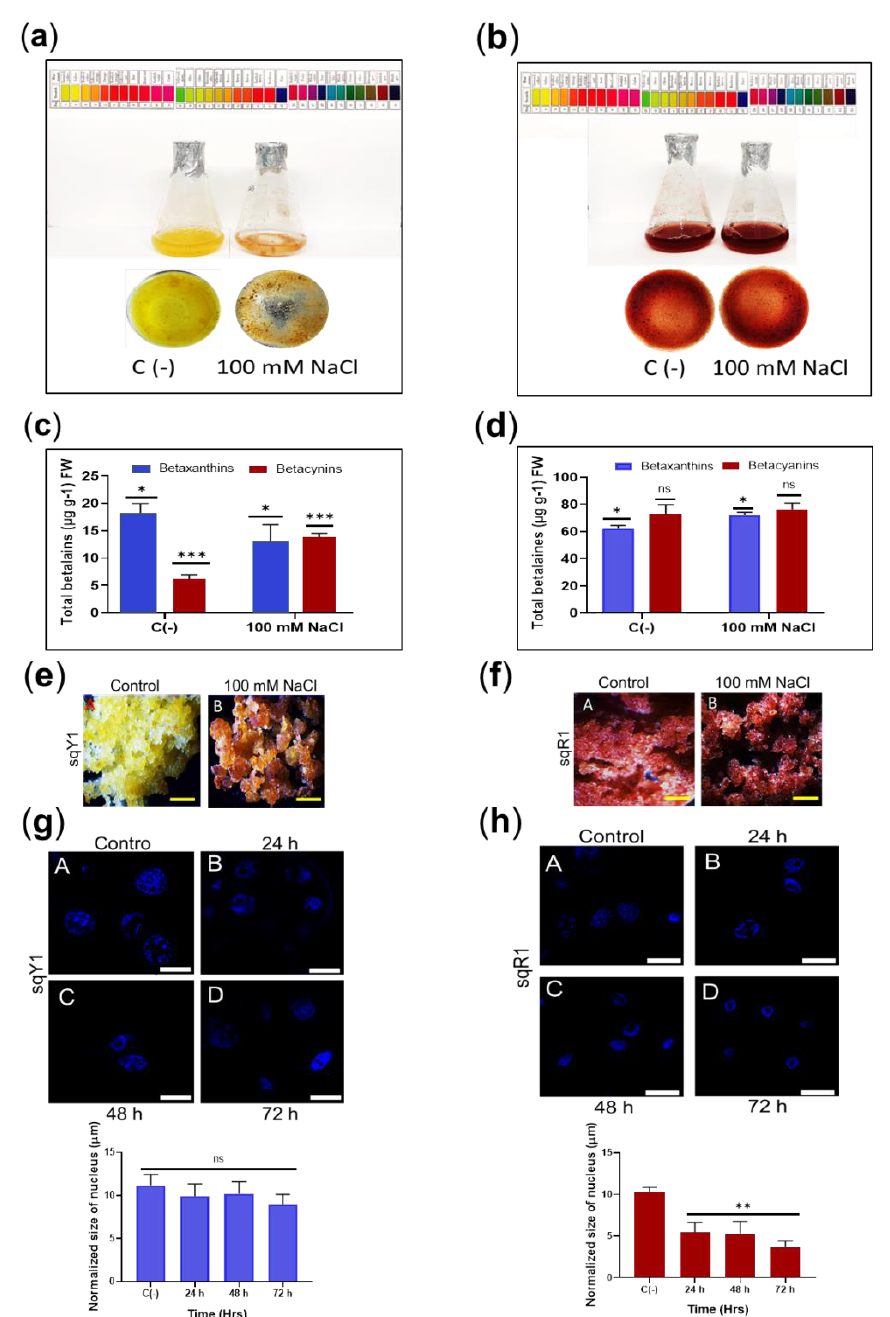
Figure 4. Salt stress in sqY1 and sqR1 cell lines. ( a ) effect of NaCl application in sqY1 line and ( b ) in sqR1 line ( c ) total quantification of betaxanthin and betacyanin under 100 mM NaCl conditions in sqY1 line and ( d ) in sqR1 line. ( e ) Cluster formation in line sqY1. Additionally, ( f ) in line sqR1. Bar scale 1 cm. ( g ) Nucleus measurements in line sqY1 and ( h ) in line sqR1. Bar scale 10 µ m. All experiments were obtained at a significance level with three independents replicates. Bars indicates standard error. (*) Indicate statistical significance at p < 0.05, (**) Indicate statistical significance at p < 0.01, (***) Indicate statistical significance at p < 0.001. (ns) Indicate no statistical significance, as described in Materials and